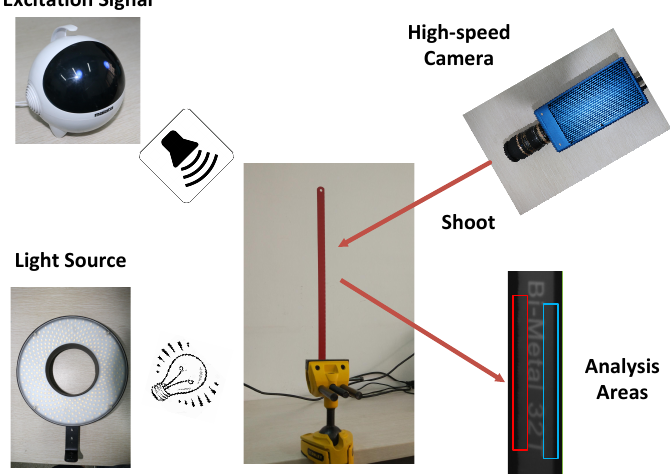
Figure 5. Setups of the beam property estimation experiment.